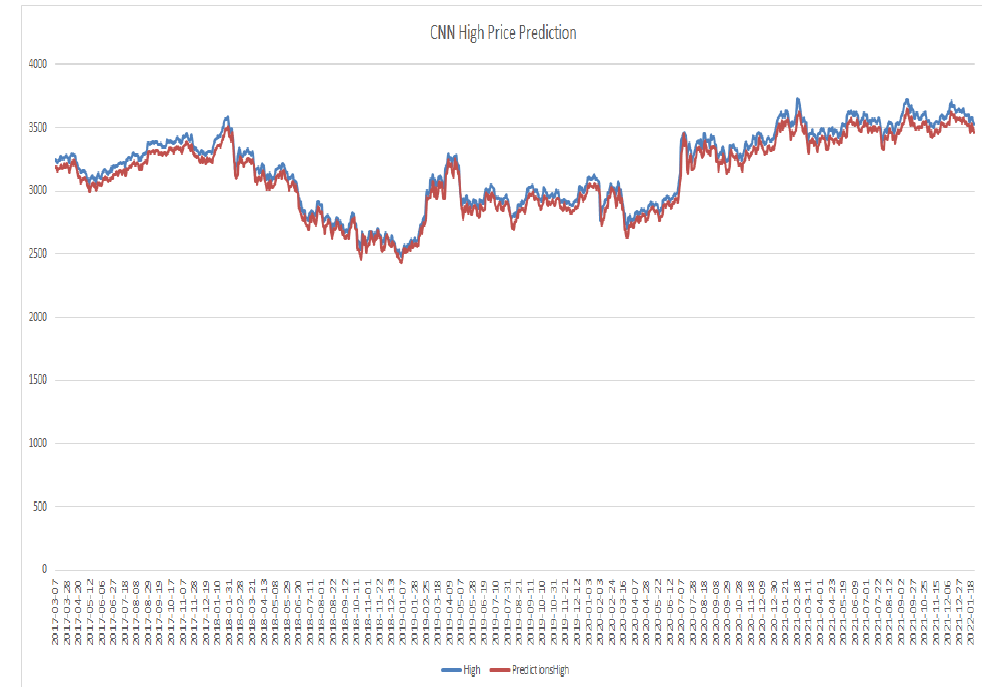
Figure 9. CNN model high price